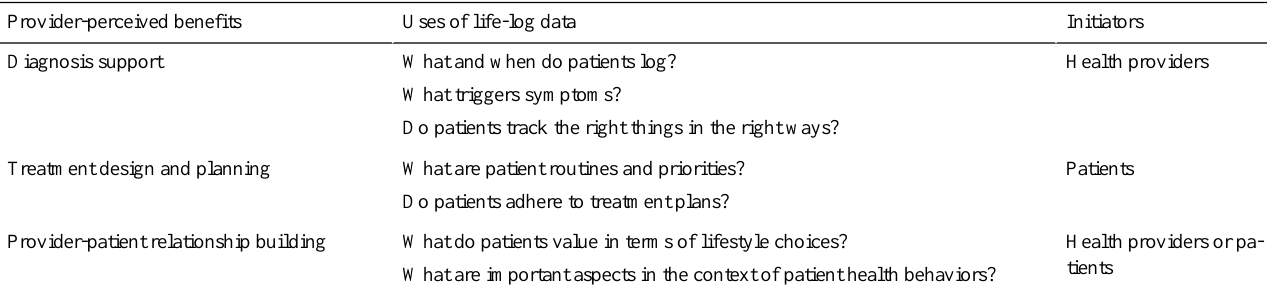
Table 3. Benefits providers achieve with life-log use in clinical care, as reported for irritable bowel syndrome and weight management.